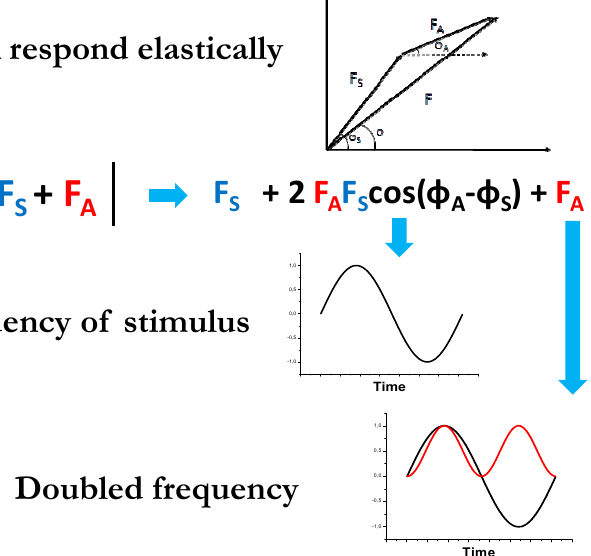
Figure 4. Pictorial demonstration of the possibility to extract information of active atoms only in a MED experiment. The crystal system is divided in silent ( S ) and active ( A ) atoms, depending on how they respond to an external stimulus applied. The diffraction response measured on the X-ray detector can be divided in two contributions from S and A atoms. This give rise to three terms, the first being constant in time, the second having the same time-dependence of the stimulus, the third varying with double the frequency of the stimulus and representing the contribution of active atoms